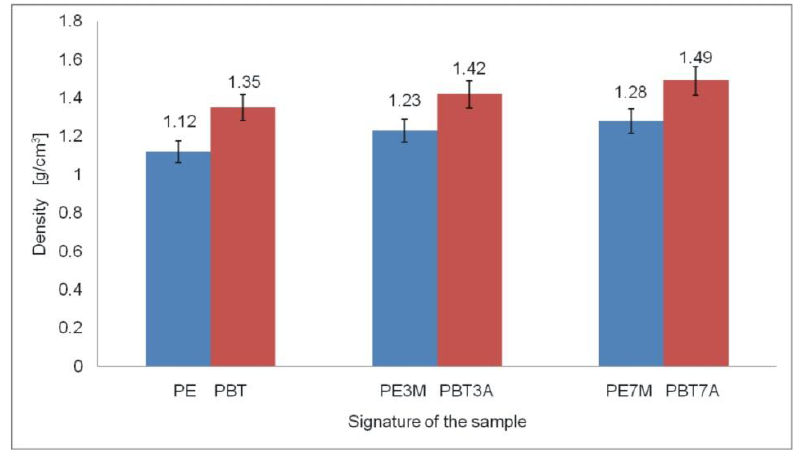
Figure 2. Density of the materials obtained.